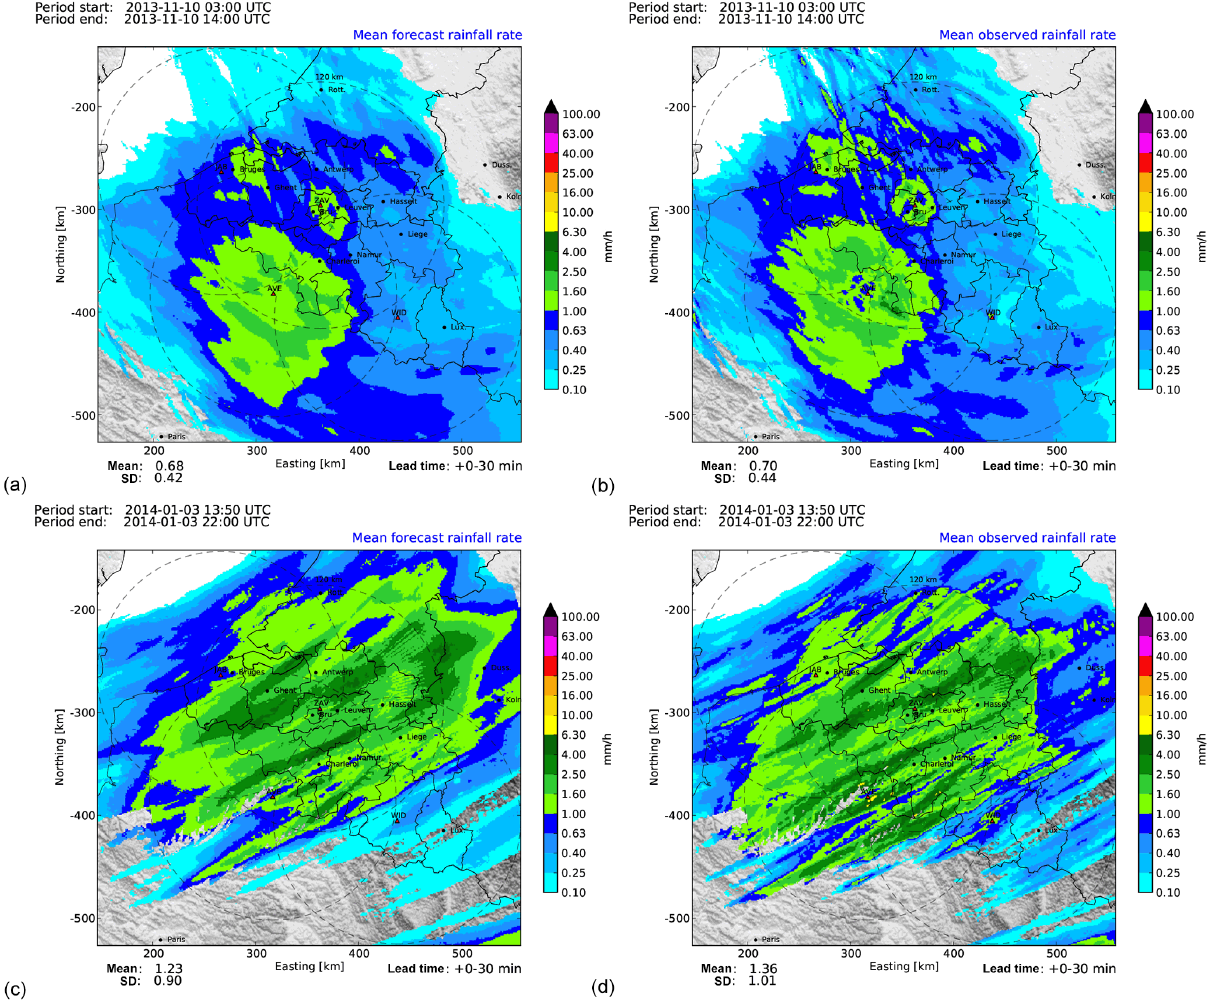
Figure 2. Average forecast and observed rainfall accumulations for the Ghent cases. (a) Forecast and (b) observed 0–30min rainfall accu- mulations on 10 November 2013. (c) Forecast and (d) observed 0–30min rainfall accumulations on 3 January 2014. The mean and standard deviation of the field within the 120km range of the radars are shown on the bottom left corner. Field values are shown only if there are at least 10 samples for the computation of the mean. The red triangles denote the location of the Wideumont (WID, coordinates 438km east/ − 405km north), Zaventem (ZAV, 363/ − 296), Jabbeke (JAB, 266/ − 263) and Avesnois (AVE, 317/ − 382) radars. The 120km range from the radar is displayed as a dashed circle. The mountain range of the Ardennes covers the three most southern districts of Belgium and Luxembourg